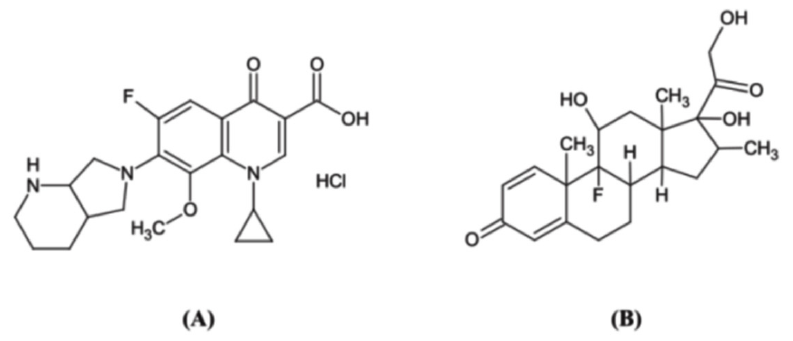
Figure 1. Chemical structures of moxifloxacin hydrochloride ( A ) and dexamethasone sodium phos- phate ( B ).